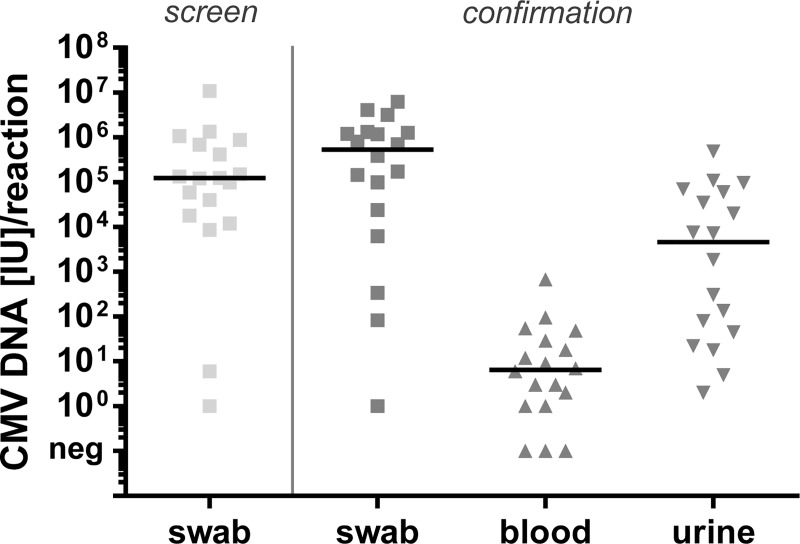
CMV DNA load in samples of study participants with confirmed cCMV infection.Fig 3 illustrates the viral load (IU CMV DNA/PCR reaction) in samples of the 18 newborns with confirmed cCMV infection. CMV DNA loads in buccal swabs at the time of the screening test (left) are compared to the CMV DNA loads in buccal swab, blood and urine at the time of confirmatory diagnostics (right). Medians are represented as black lines.